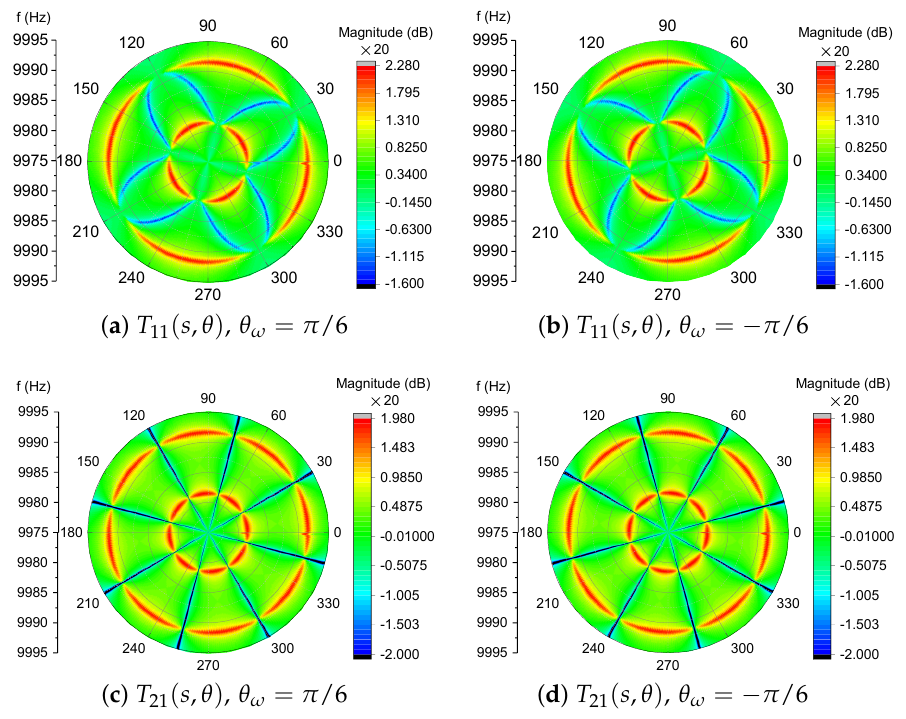
Figure 3. The magnitude-frequency responses of the 2D transfer function T 11 ( s , θ ) . Table 1. Parameters of the transfer functions in Figure 3. Parameters